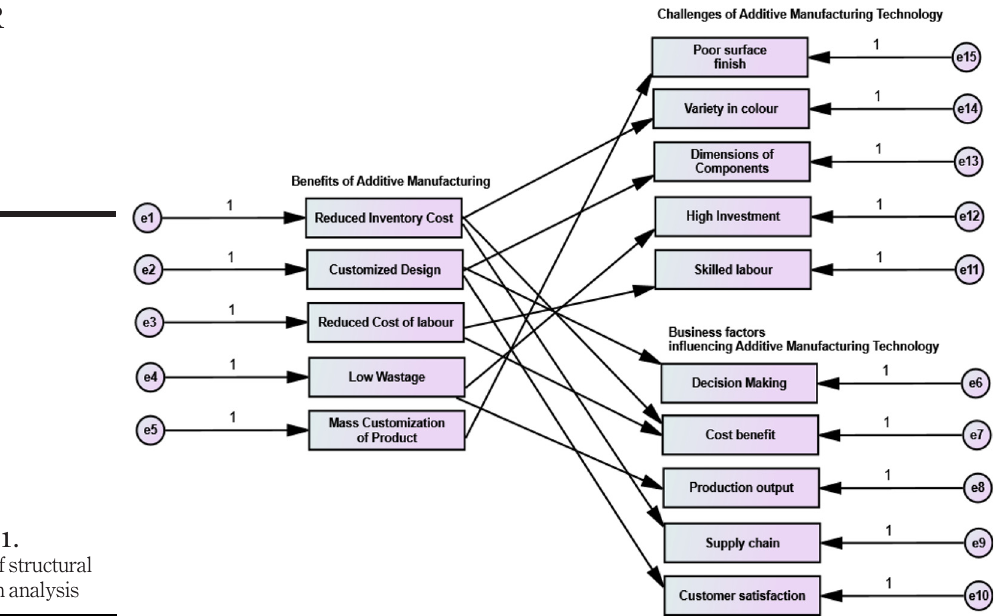
Figure 1. Model of structural equation